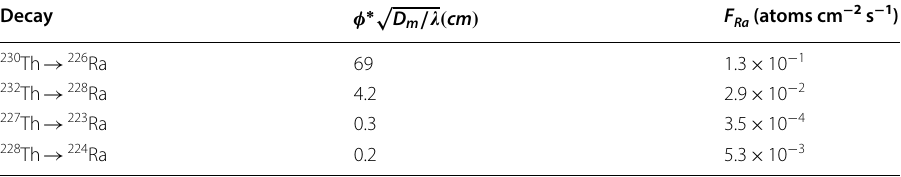
Table 11 Model-derived rates of diffusional flux F length (φ ∗ (cid:31) D m / (cid:31) ) for radium isotopes Decay φ ∗ (cid:31) D m / (cid:31) ( cm